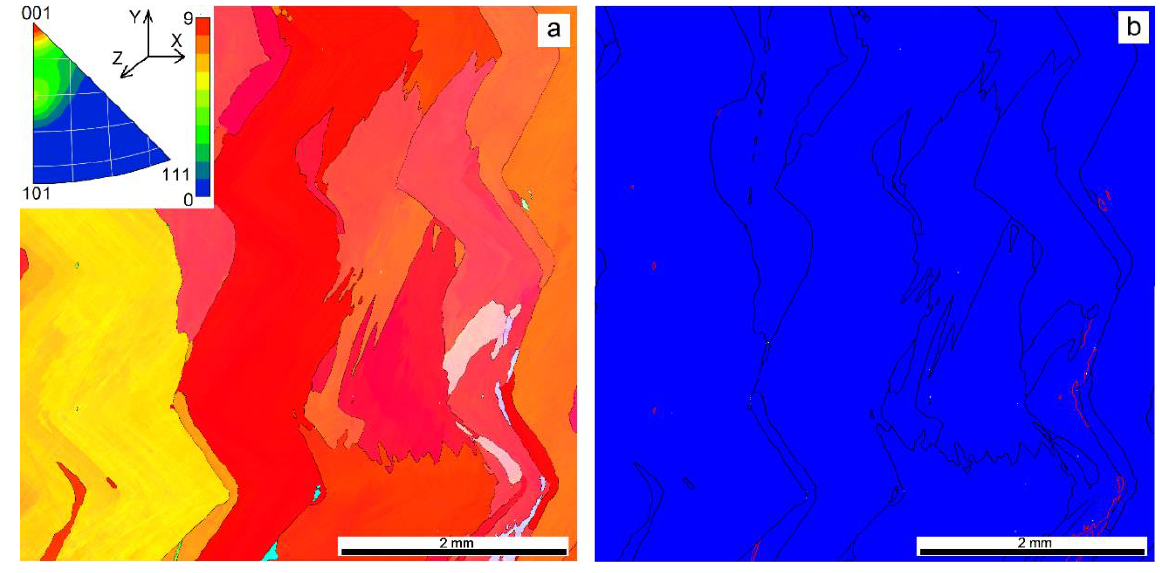
Figure 8. EBSD grain orientation distribution ( a ) and grain boundary types ( b ) in a cross section of the Cu-7.5wt.%Al wall obtained at heat input of 0.255 kJ/mm.